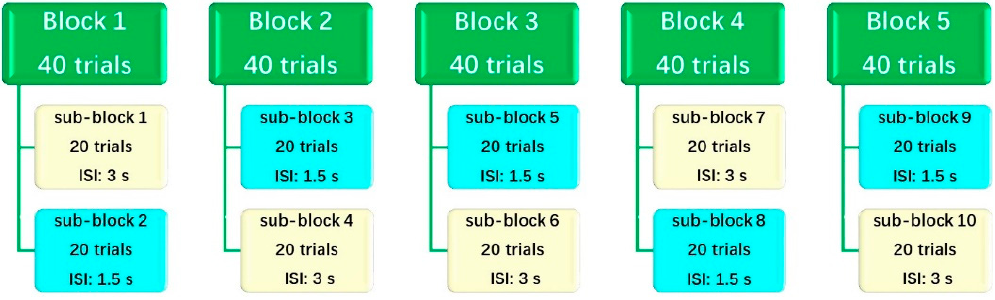
Figure 2. The structure of K-CPT.